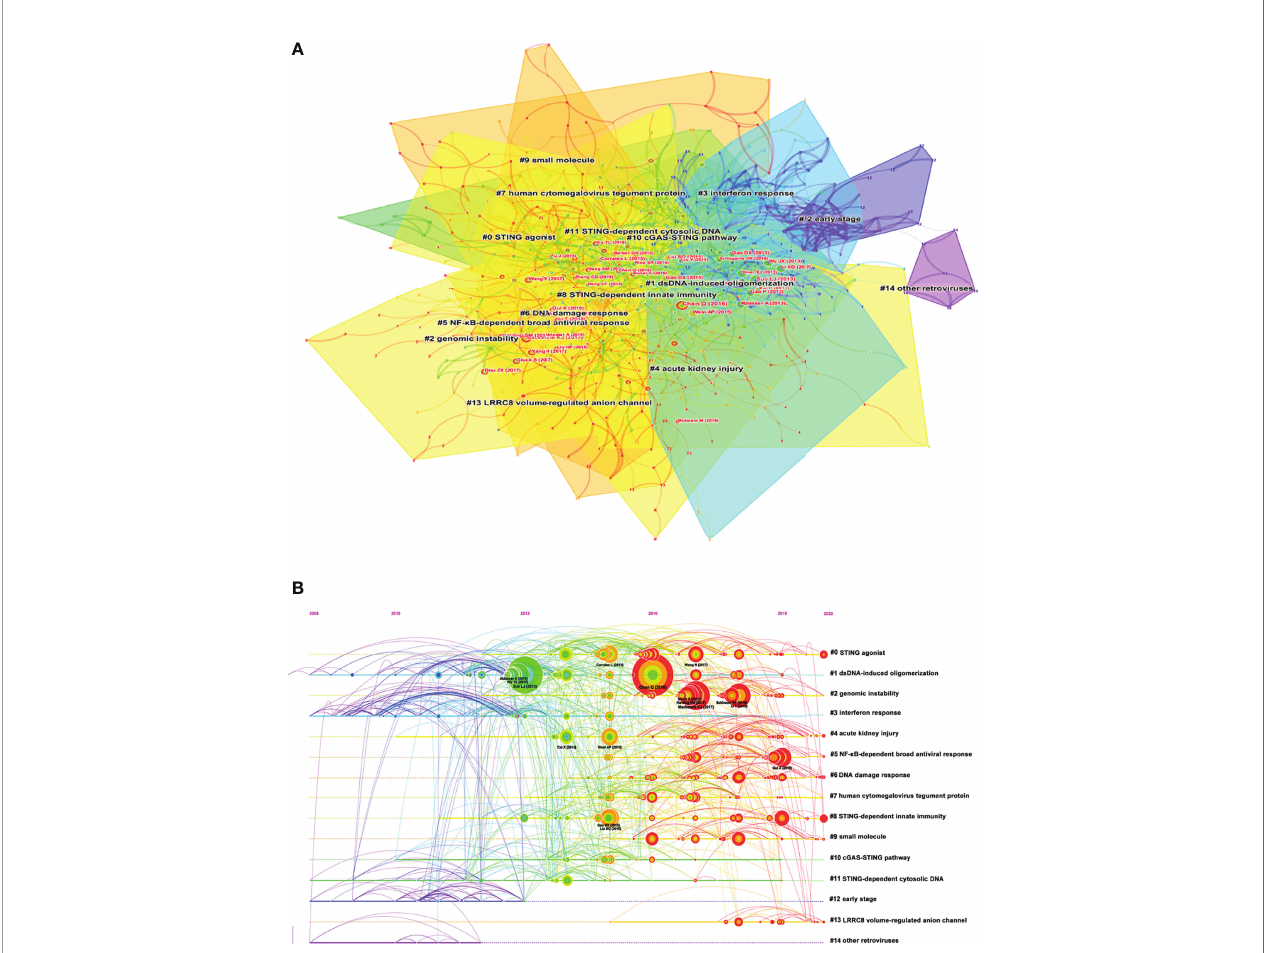
FIGURE 6 | (A) The clustered network map of co-cited references on the cGAS-STING pathway. (B) The timeline view of co-citation clusters with their cluster-labels on the